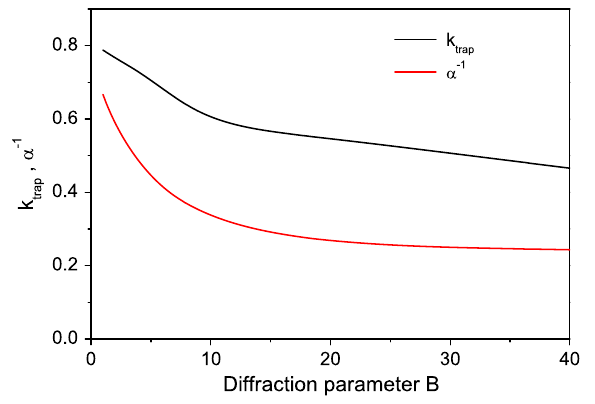
FIG. 5. Evolution along the undulator of the squared value of the bunching factor for the FEL amplifier with global undulator FIG. 4. The trapping efficiency K for the globally optimized trap tapering. Color codes: black, red, green curves correspond to the undulator (black curve) and the fitting coefficient α − 1 of the tap value of the diffraction parameter B ¼ 1 , 10, and global optimization entering Eq. (5) (red